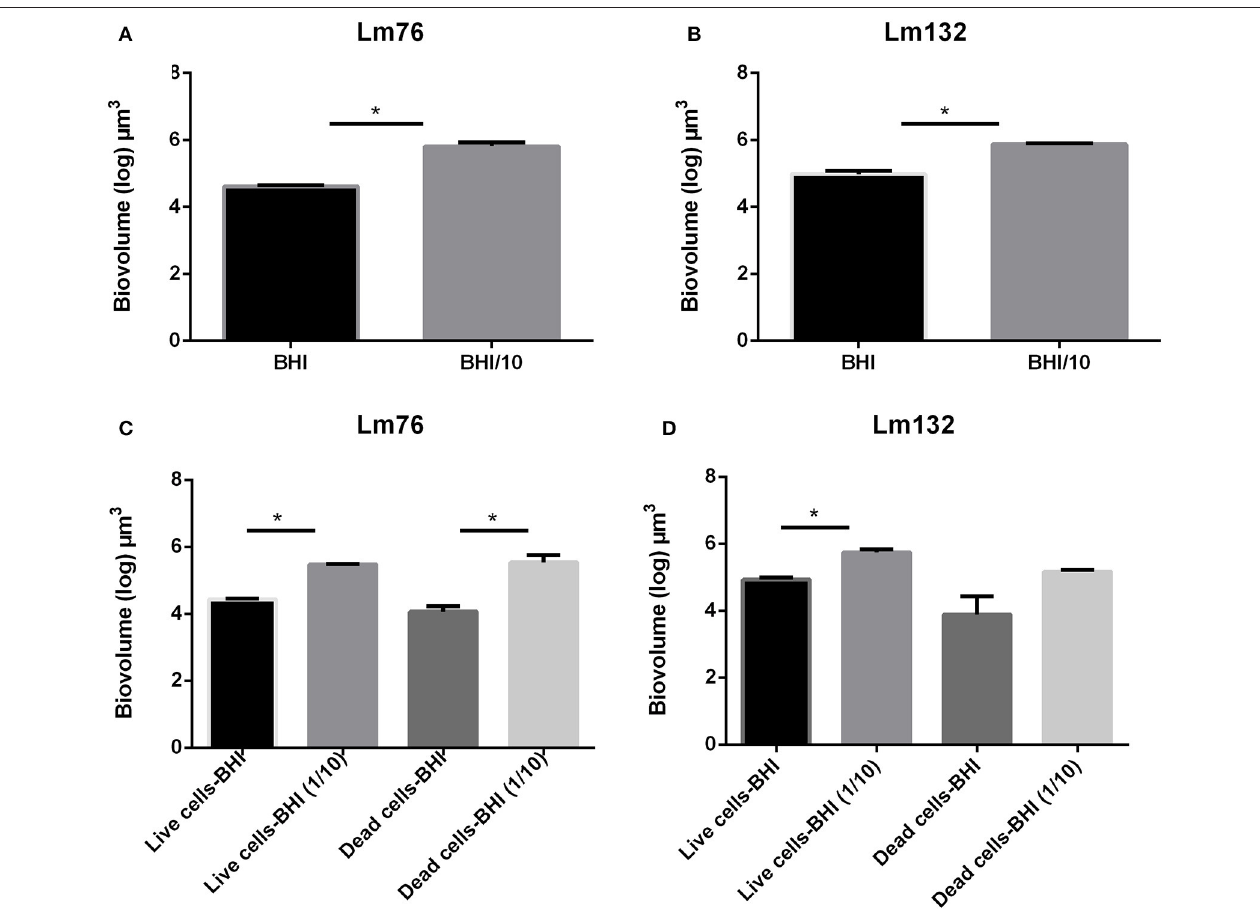
FIGURE 4 | Biovolume calculation of biofilm formed in microfluidic conditions by Listeria monocytogenes Lm76 and Lm132 strains grown in a rich medium BHI and poor medium BHI/10 for 24 h at 30 ◦ C; (A,B) Total biovolume of biofilm formation by Lm76 and Lm132 strains respectively which corresponds to the some of the live and dead biomass in each biofilm; (C,D) Biovolume of live (green cells) and dead (red cells) biomasses in Lm76 and Lm132 biofilm, respectively. * P <